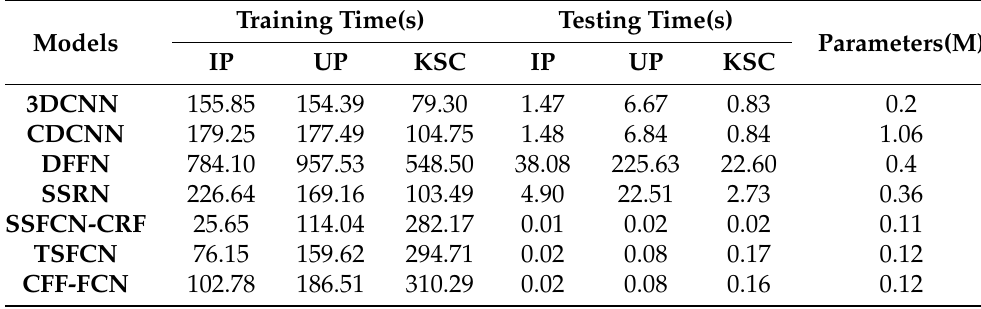
Table 7. Comparison of running efficiency between different